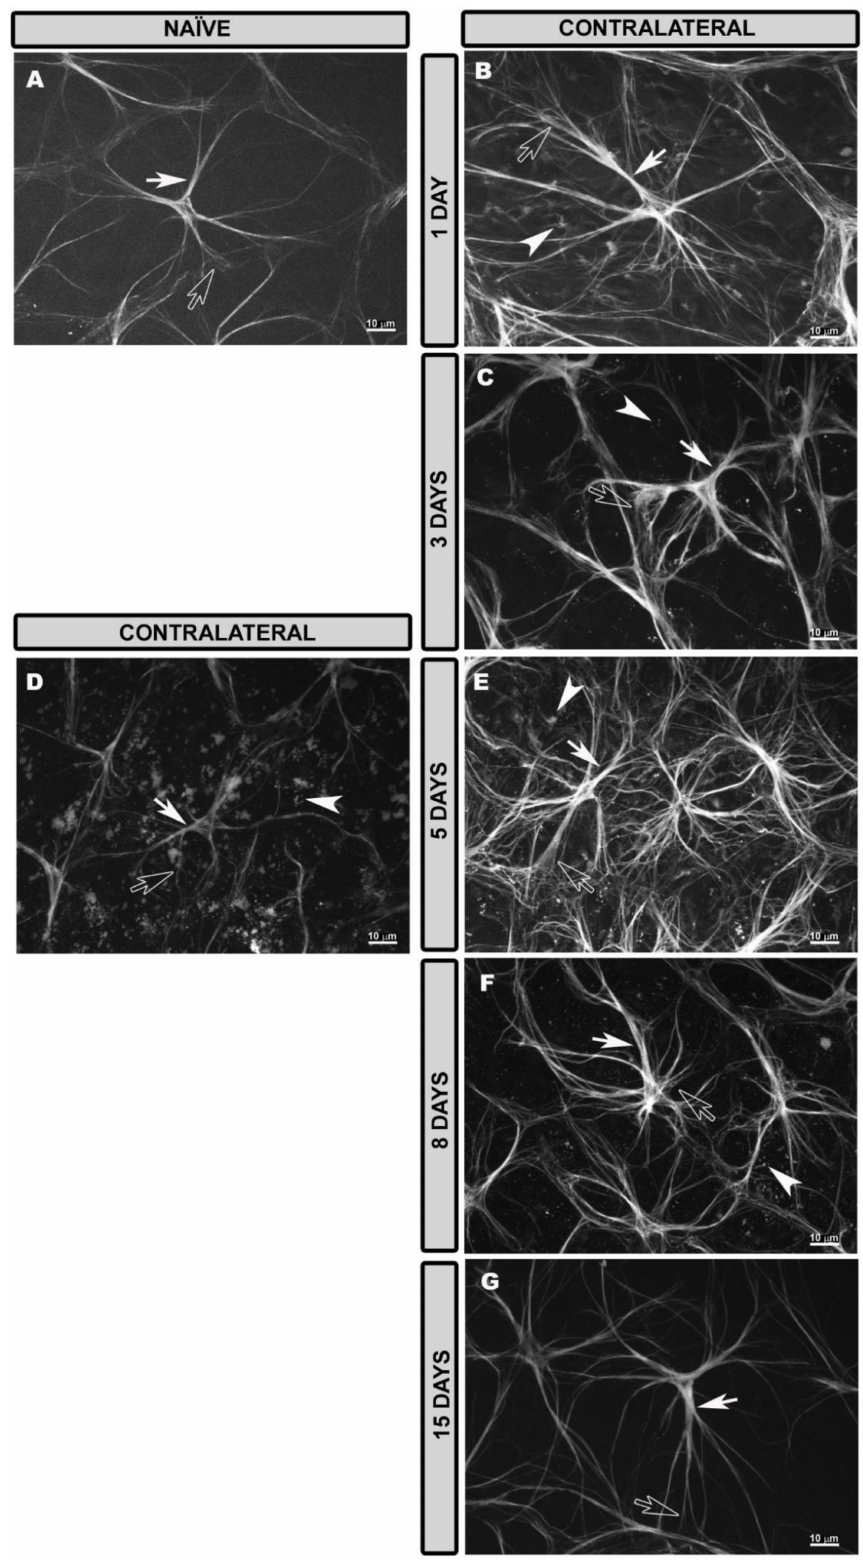
Figure 1. Retinal whole-mount. GFAP immunostaining in naïve eyes and at different time points after OHT induction in contralateral eyes (high magnification). Morphological characteristics of